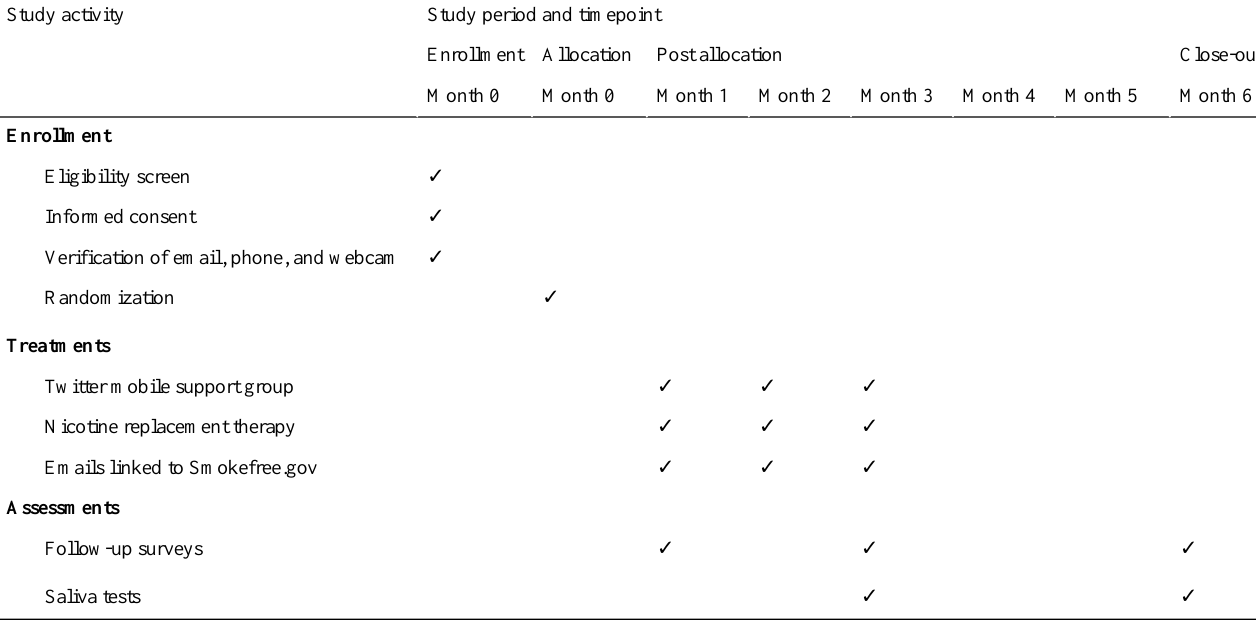
Table 1. Study flow.